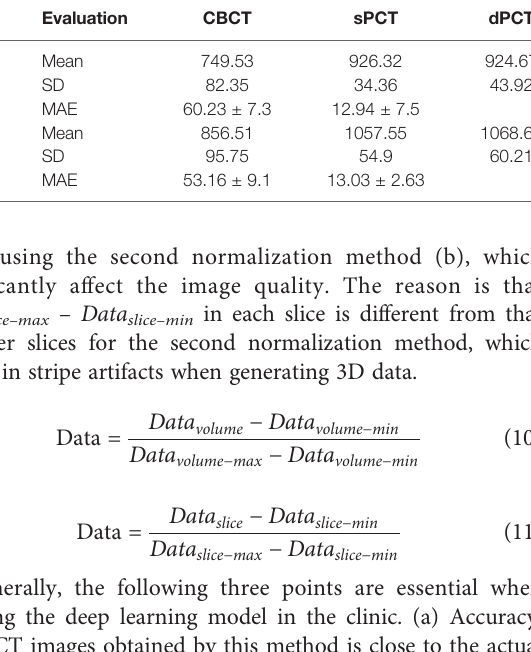
TABLE 3 | Mean, standard deviation, and MAE of CT numbers of ROIs in CBCT, sPCT, and dPCT. ROI Evaluation CBCT sPCT dPCT Fat